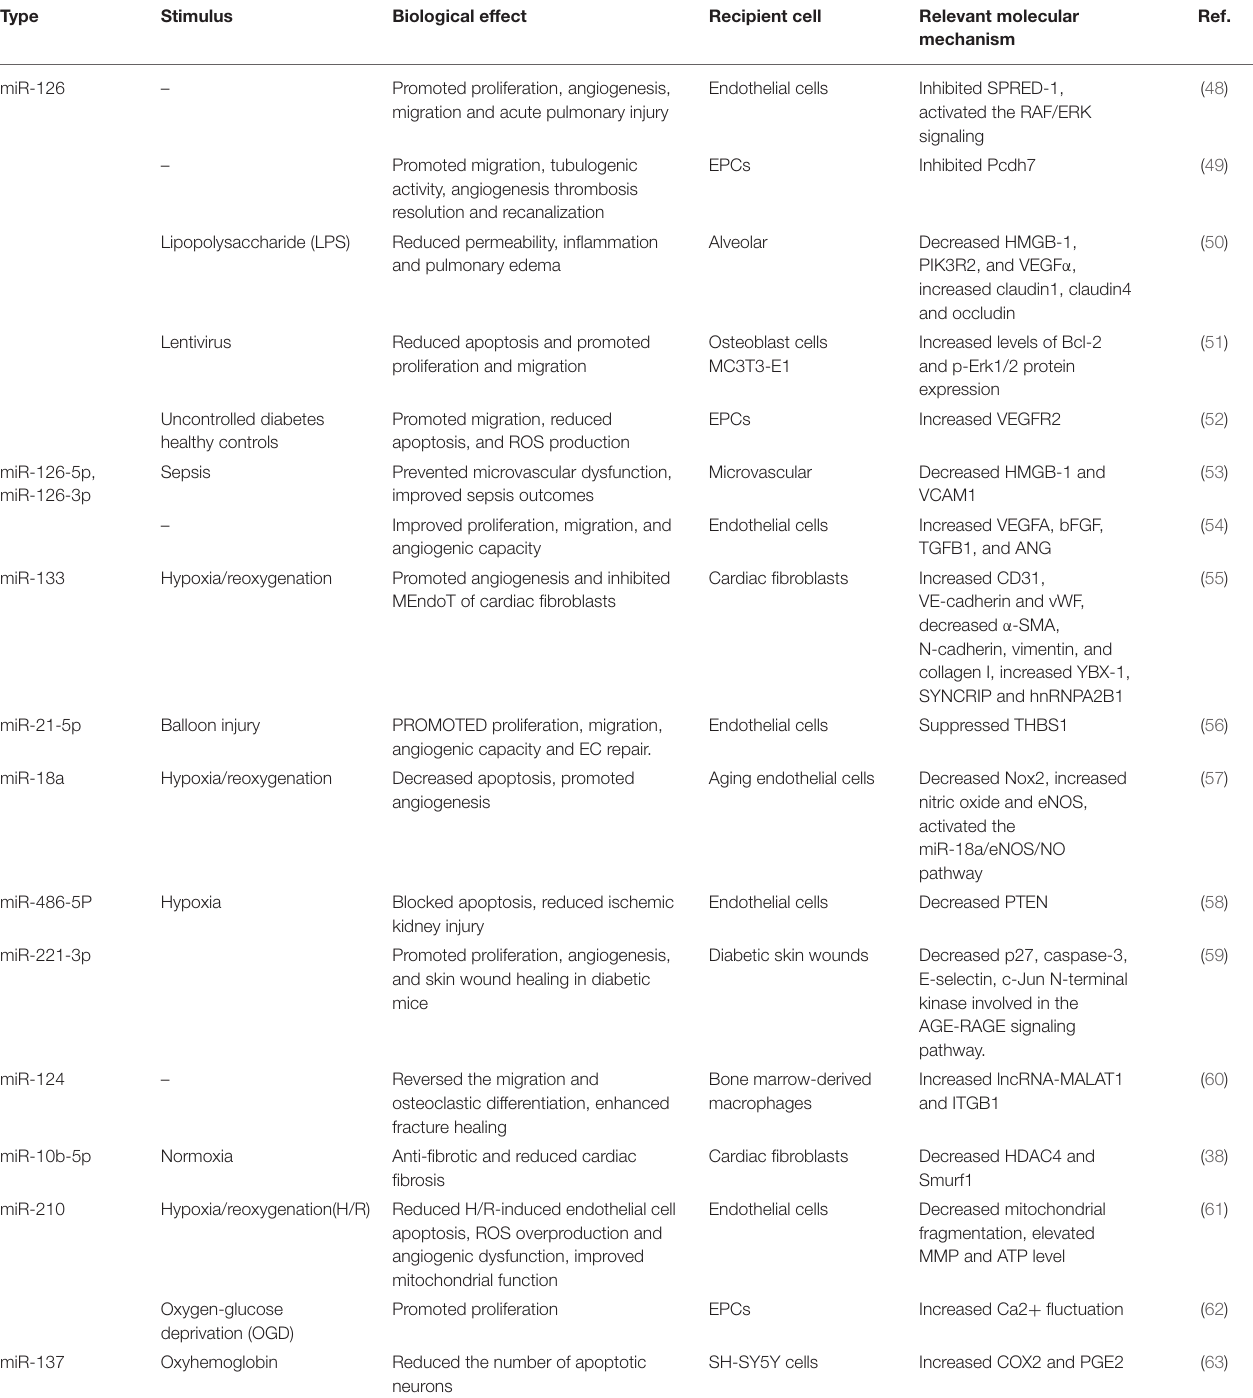
TABLE 2 | Manuscripts demonstrating the functional effects of miRNA in EPCs-derived microvesicles/exosomes in cardiovascular diseases.